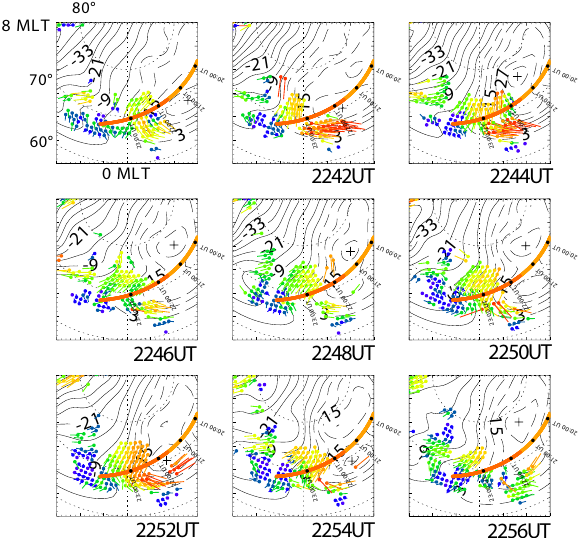
Fig. 9. SuperDARN map potential plots at two-minute intervals with the true vectors superposed from 22:40 until 22:56 UT on 1 September 2002 and with Cluster 1 footprint also superposed.